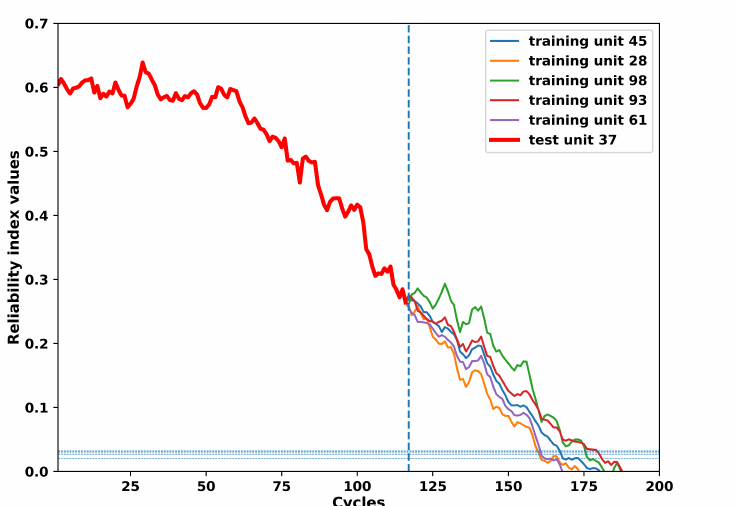
Figure 11. Predictions of the incomplete reliability index of the test set unit 37th considering its five most similar reliability indices of the training set units. The online prediction of the reliability index for the unit 37th in the test set is updated by future values of the external operational conditions which are predicted by means of the FGM model.